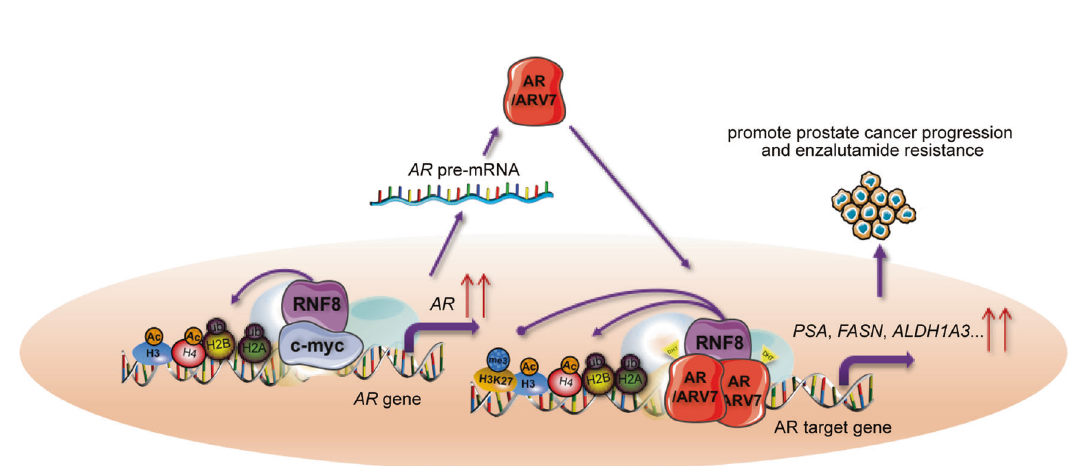
Fig. 7 RNF8 depletion inhibits cell proliferation and enhances enzalutamide sensitivity in prostate cancer cell lines. A , B Control and stable RNF8 knockdown LNCaP ( A ) and 22Rv1 ( B ) cells were treated with vehicle or DHT (10 − 8 M) for 10 days. The cell colonies were stained with Coomassie blue. C , D Control and stable RNF8 knockdown LNCaP ( C ) and 22Rv1 ( D ) cells were treated with vehicle or DHT (10 − 8 M) for 0, 1, 2, 3 days. The cell viability was detected by the CCK8 proliferation assay. Data were means ± SEM ( n = 3). ** P < 0.01; *** P < 0.001; **** P < 0.0001 (two-sided unpaired t -test). E The proliferation of control and stable RNF8 knockdown DU145 cells was examined by the CCK8 assay. Data were means ± SEM ( n = 3). ns no signi fi cance (two-sided unpaired t -test). RNF8 knockdown ef fi cacy was determined by western blot. Numbers under the western blot bands indicate the relative gray value normalized to β -actin. F The photograph for the xenografts from NOD/ SCID mice injected subcutaneously with control and stable RNF8 knockdown 22Rv1 cells ( n = 8). G , H The median of tumor volume ( G ) and tumor weight ( H ) from ( F ). ** P < 0.01 (two-sided Mann – Whitney test). I Representative images of xenograft tumor tissues in ( F ) staining with RNF8, FASN, and ALDH1A3. The H&E staining was also presented. Scale bar, 50 μ m. J Statistical analysis of the mean staining intensity of RNF8, FASN, and ALDH1A3 in xenograft tumor tissues in ( I ). ** P < 0.01; *** P < 0.001; **** P < 0.0001 (two-sided unpaired t -test). K Control and stable RNF8 knockdown 22Rv1 cells were treated with vehicle or enzalutamide (10 µM) for 10 days. The cell colonies were stained with Coomassie blue. L , M Control and stable RNF8 knockdown 22Rv1 ( L ) and LNCaP-EnzR ( M ) cells were treated with vehicle or enzalutamide (10 µM) for 0, 1, 2, 3 days. The cell viability was detected by the CCK8 assay. Data were means ± SEM ( n = 3). * P < 0.05; *** P < 0.001; **** P < 0.0001 (two-sided unpaired t -test).